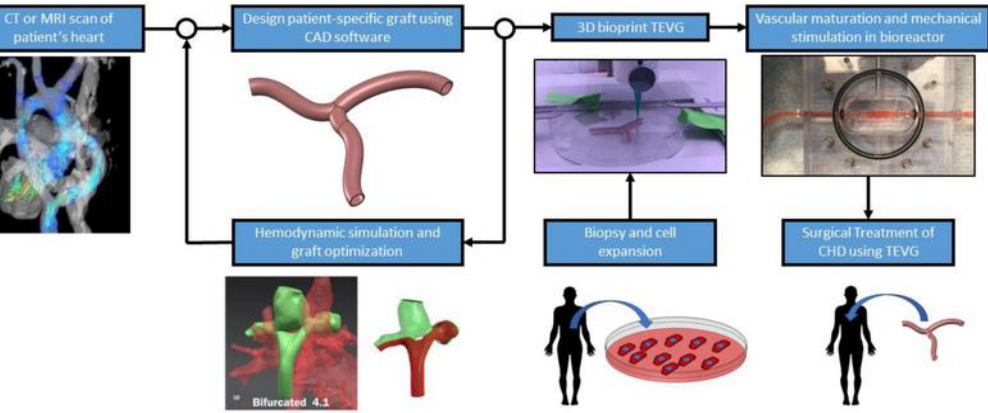
Figure 15. Proposed workflow of patient-specific TEVG fabrication. CAD-computer aided design, TEVG — tissue engineered vascular grafts. Reprinted with permission from Lee et al. [107].